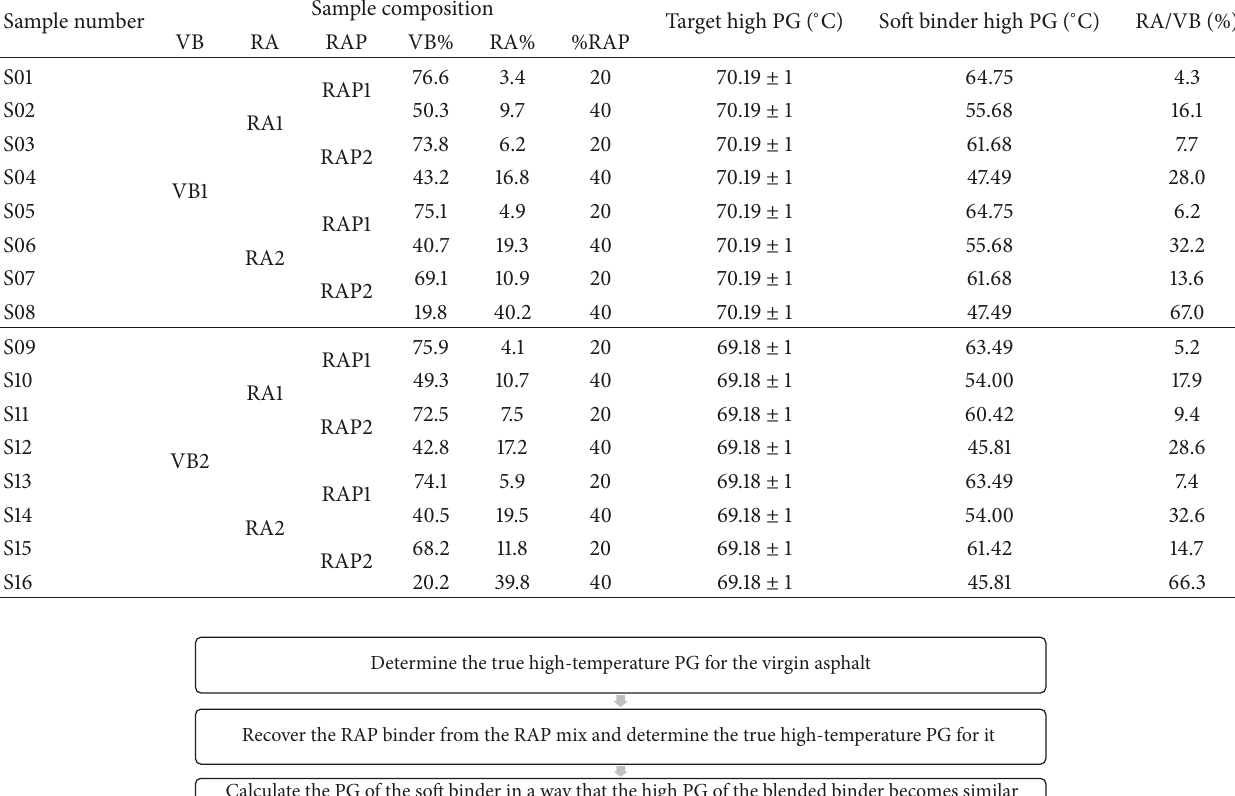
Table 2: Factorial design and composition of samples.